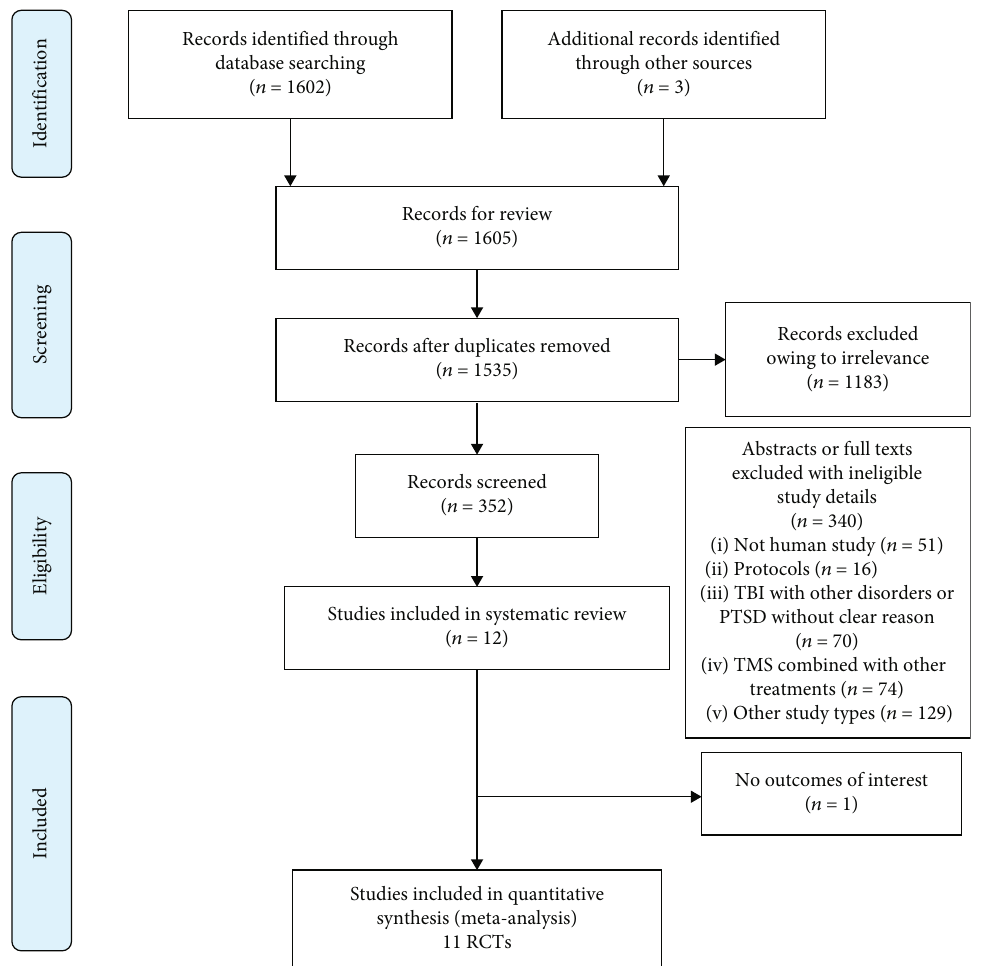
Figure 1: Flow diagram of the selection